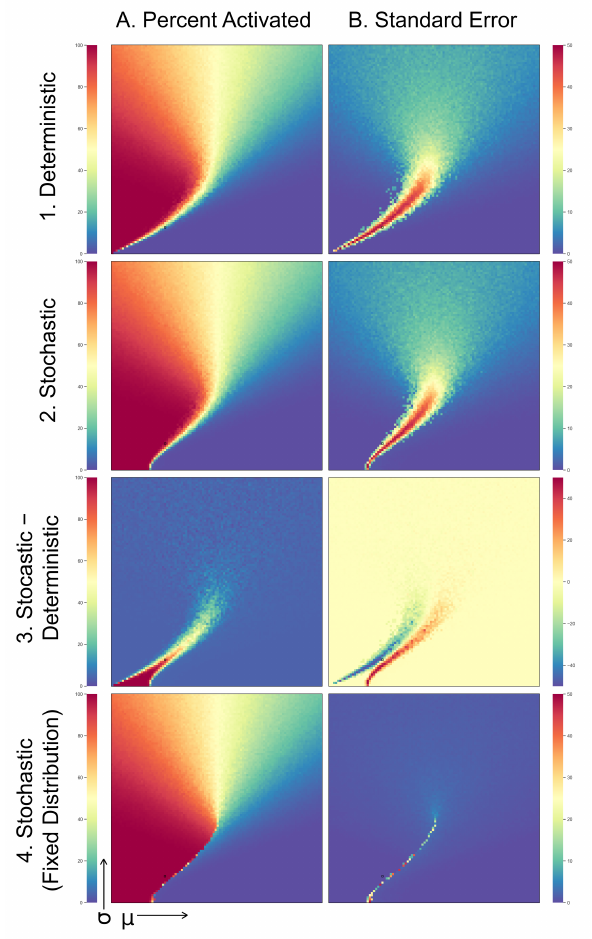
Figure 6: Unpredictability of activation level across an expanded parameter space. The heat map measures the level and unpredictability of cascade outcomes across 100 samples ( N = 100) randomly drawn from an underlying population with thresholds normally distributed around a mean µ = { 0, . . . , 100 } (from left to right on the x axis within each of the eight cells) and standard deviation σ = { 0, . . . , 100 } (from bottom to top on the y axis). Column A reports the percentage activated after 100 time steps, from indigo (0) to red (100). Column B reports the standard error from indigo (0) to red (50), except row 3 (–50 to 50). Row 3 reports the difference between deterministic thresholds (row 1) and stochastic thresholds (row 2, with m = 0.2). Row 4 reports the percentage activated and standard error attributable entirely to activation